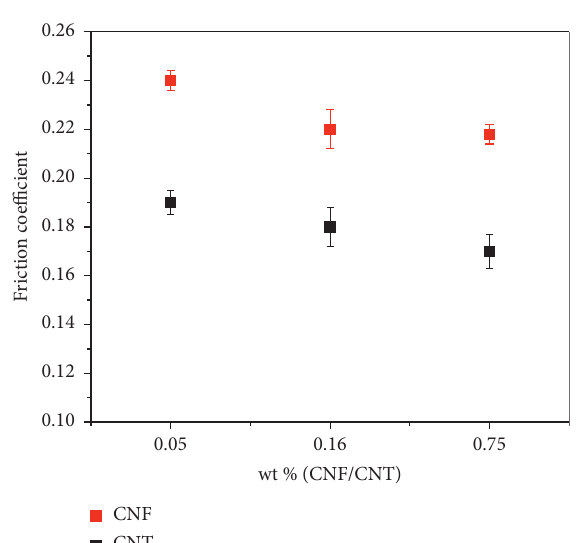
Figure 6: Tribological properties of PVDF/CNF and PVDF/CNTwith various wt%: load:1 N, sliding speed: 2 cm/s (linear speed), ball: steel (100Cr6, diameter 6 mm), sliding cycles: 10000, and condition: room temperature and ambient